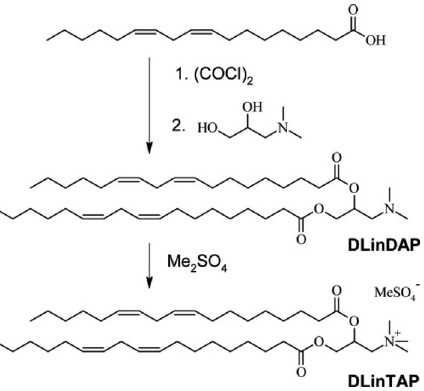
Figure 2. Synthesis of DLinTAP. The full details of the synthesis are reported in the Supplementary Information.